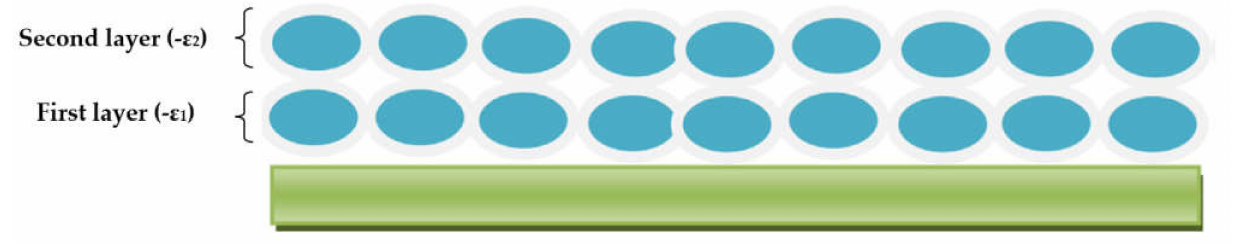
Figure 2. Schematic illustration of the distribution of the molecules adsorbed on a solid according to the double layer model with two